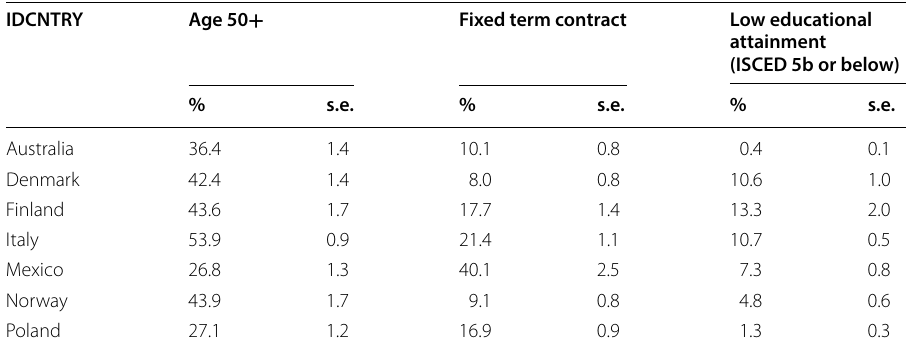
Table 15 Selected characteristics of upper secondary teachers population, 2013 (Source: Author’s calculations based on OECD, TALIS 2013)